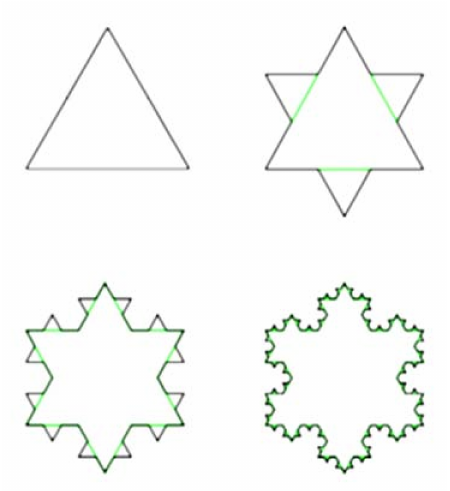
Figure 1. A representation of the Koch Snowflake showing the principle of fractal self-similarity. The triangular divisions are perfectly proportional to one another and continue into infinity. Modified from WXS, Wikimedia